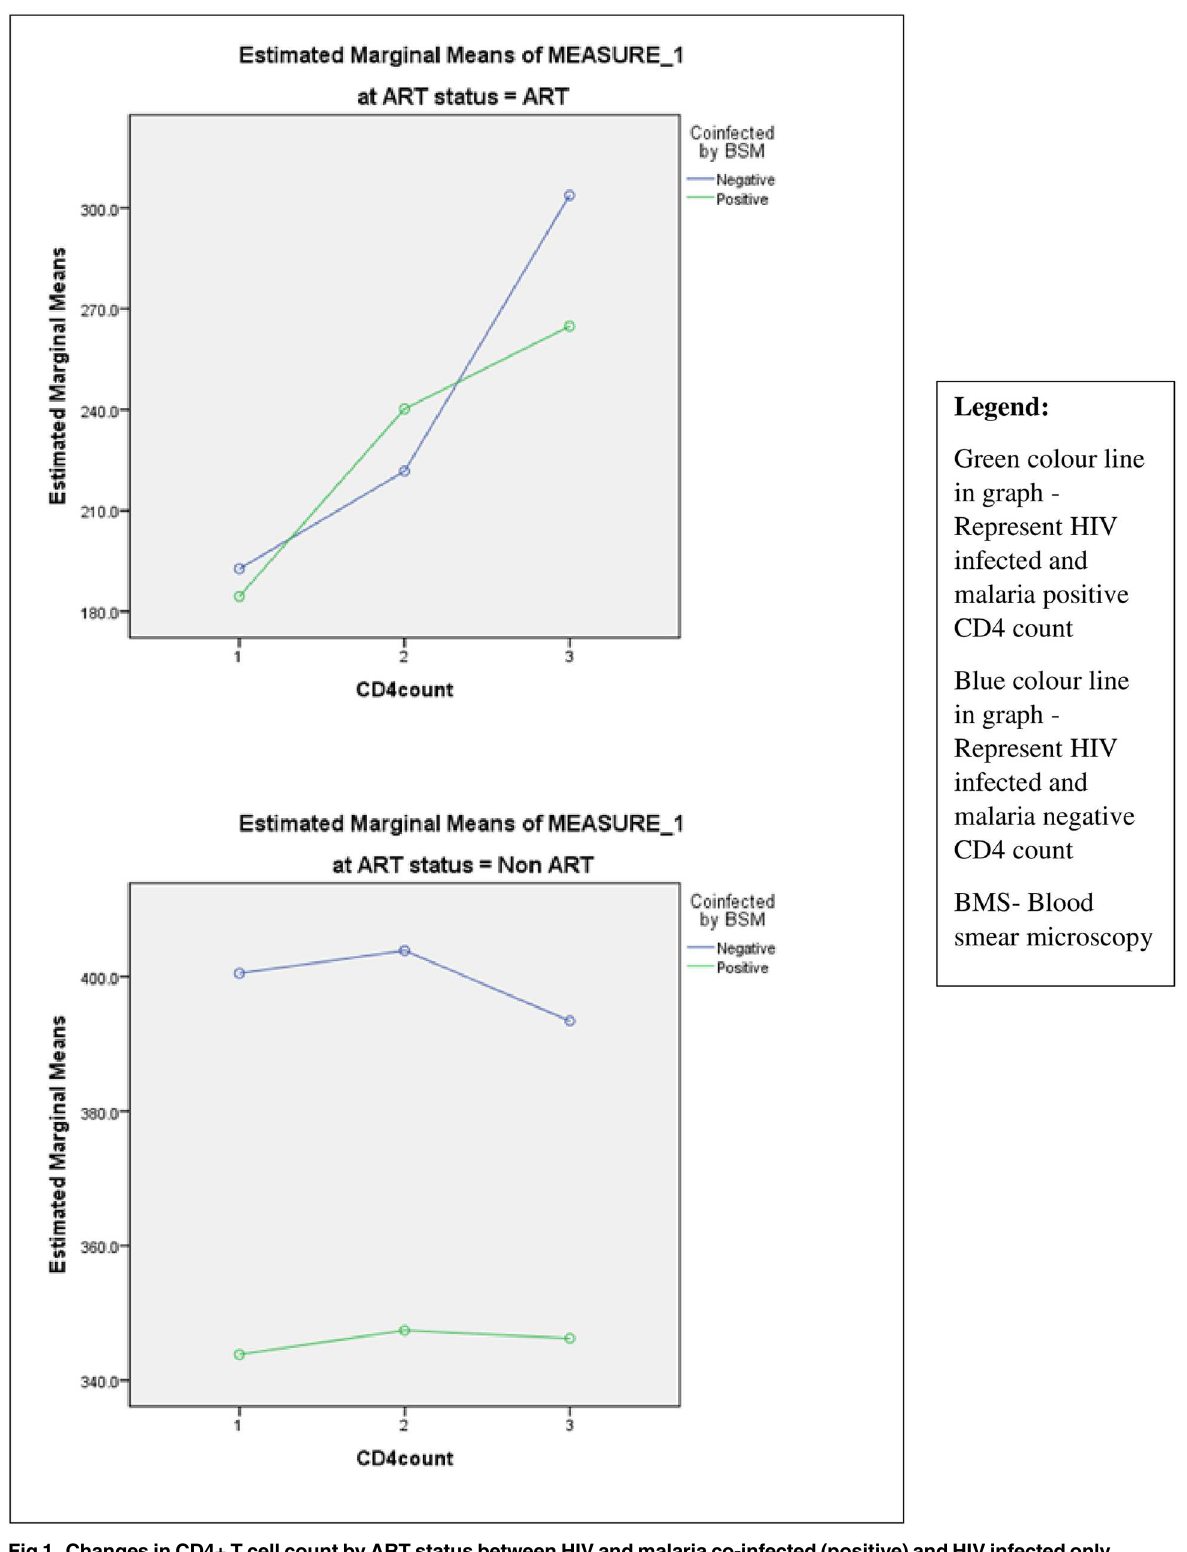
Fig 1. Changes in CD4+ T cell count by ART status between HIV and malaria co-infected (positive) and HIV infected only (malaria negative) patients. 1 –Baseline CD4; 2- Follow-upCD4 count; and 3- Current CD4 count among HIV patients attendingART clinic in Infectious DiseaseHospitalKano from June to December2015. https://doi.org/10.1371/journal.pone.0174233.g001 PLOS ONE | https://doi.org/10.1371/journal.pone.0174233 March 27,